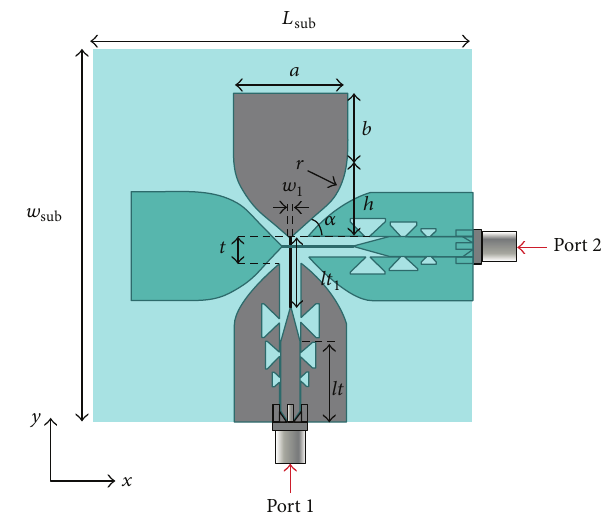
Figure 4: Geometry of the proposed antenna.